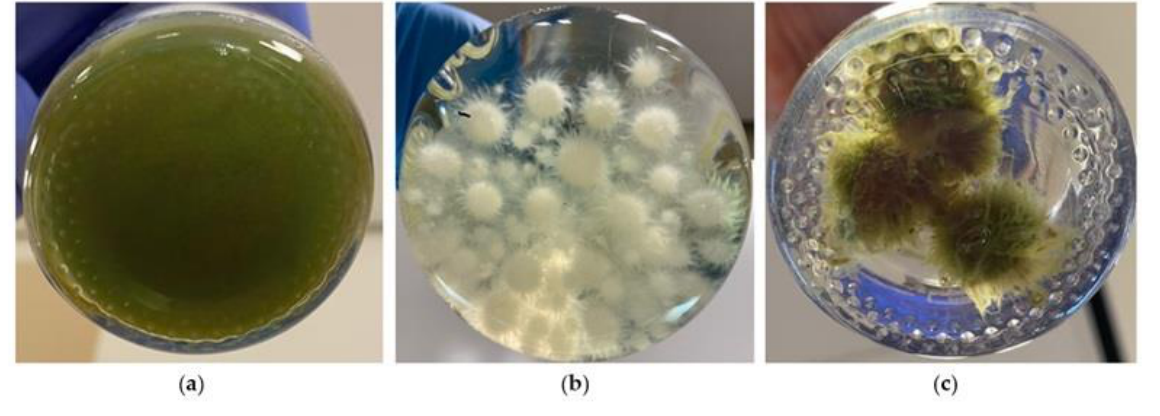
Figure 2 . ( a ) T. obliquus suspension before bio-flocculation; ( b ) I. lacteus culture in liquid medium before adding to the T. obliquus suspension; ( c ) algal-fungal pellets formed in T. obliquus — I. lacteus complex after 24 h.